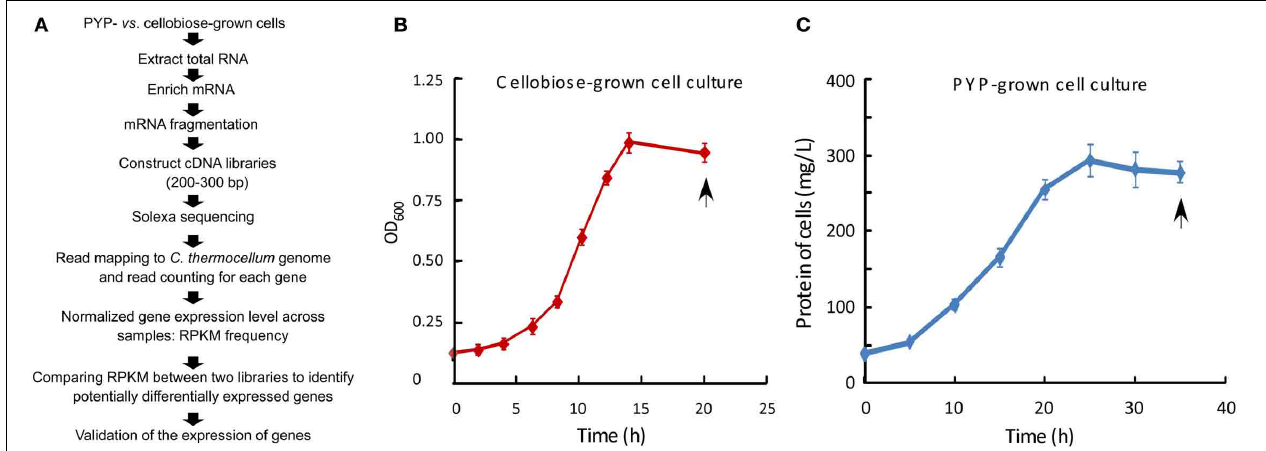
FIGURE 1 | Flowchart for experimental procedures, along with growth curves for cellobiose- and PYP-grown C. thermocellum cells. (A) Flowchart outlining the experimental procedures; RPKM, reads per kilobase of exon model per million mapped reads. (B) OD 600 for cellobiose-grown cells was measured by spectrophotometry at 600nm